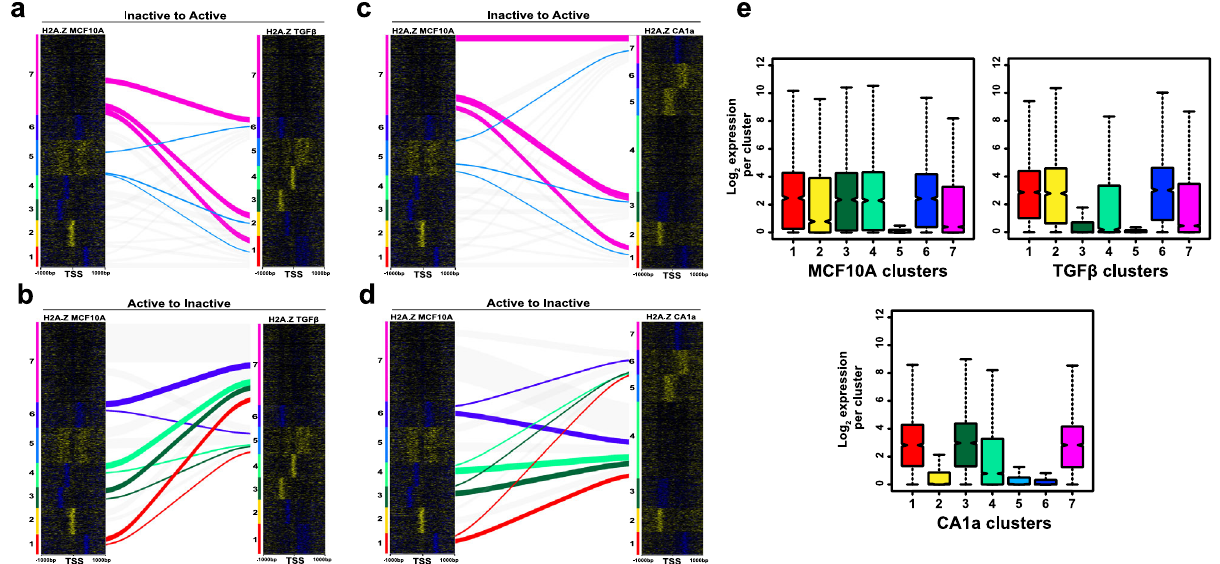
Fig. 3 How different promoter H2A.Z MNase sensitive or resistant structures in MCF-10A cells change following TGF- β treatment and malignant transformation. a Alluvial diagram of how H2A.Z repressed clusters 5 and 7 change following their activation when MCF-10A cells are induced with TGF- β . b Alluvial diagram showing the fate of active promoter clusters to repressed clusters 5 and 7 following their inhibition of transcription when MCF-10A cells are induced with TGF- β . c Alluvial diagram of how H2A.Z repressed clusters 5 and 7 change following their activation when MCF-10A cells become malignant. d Alluvial diagram showing the fate of active promoter clusters to repressed clusters 4 and 6 following their inhibition of transcription when MCF-10A cells become malignant. e gene expression box plots for the different MCF-10A, MCF-10A + TGF β and MCF-10CA1a MNase-sensitive promoter classes. Box plots represent the data in quartiles with the median shown as a notch, with the middle 50% of the data contained in the box, and the minima and maxima shown with the upper and lower whiskers representing Q1 and Q4. RNA-seq was performed in three independent biological